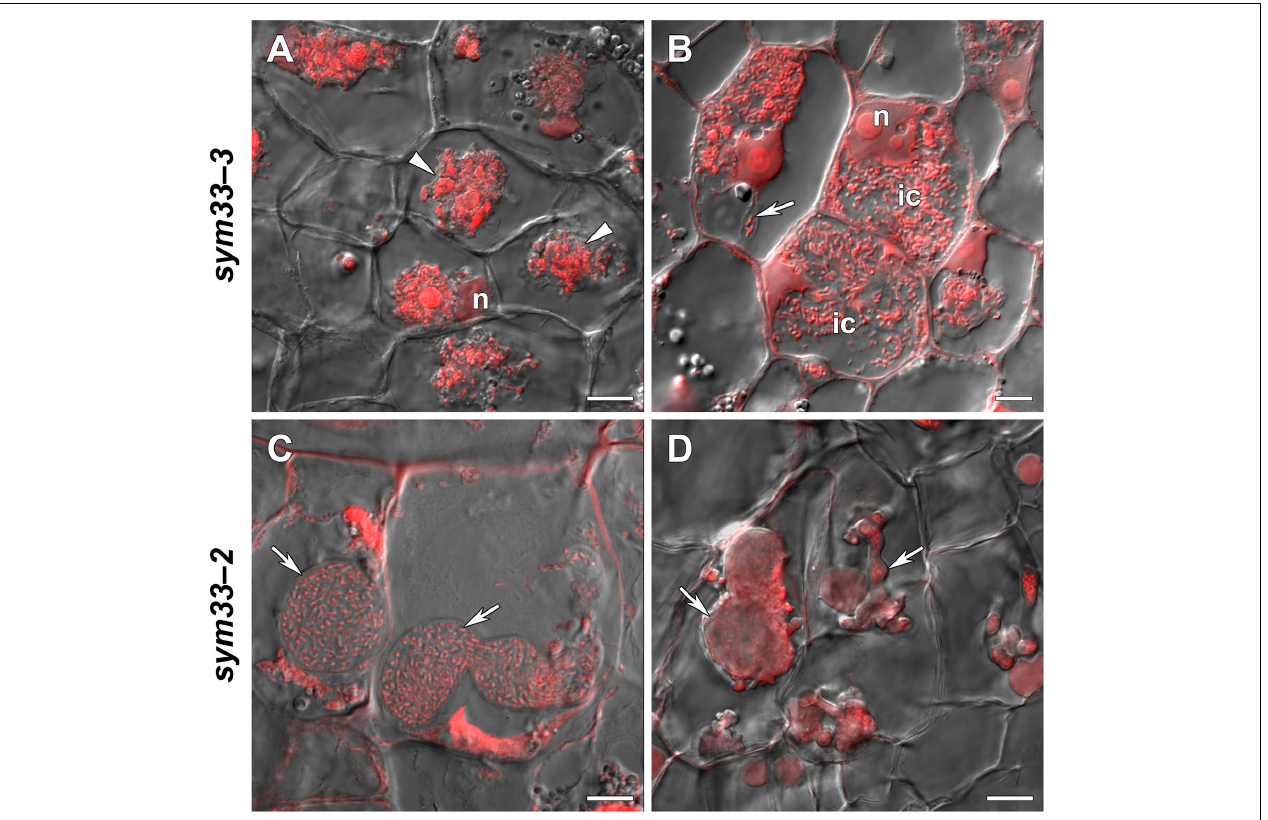
FIGURE 12 | Two-week-old nodules from mutant ( sym33-3 and sym33-2 ) pea ( Pisum sativum ) plants treated with 1 mM glutathione (GSH). (A,B) sym33-3 and (C,D) sym33-2 . Confocal laser scanning microscopy images of 50- µ m-thick longitudinal sections. Merge of differential interference contrast and the red channel. A single optical section is presented. DNA (bacteria and nuclei) is presented in red. n, nucleus; ic, infected cell. Arrows indicate infection threads; arrowheads indicate infection droplets. Scale bar = 10 µ